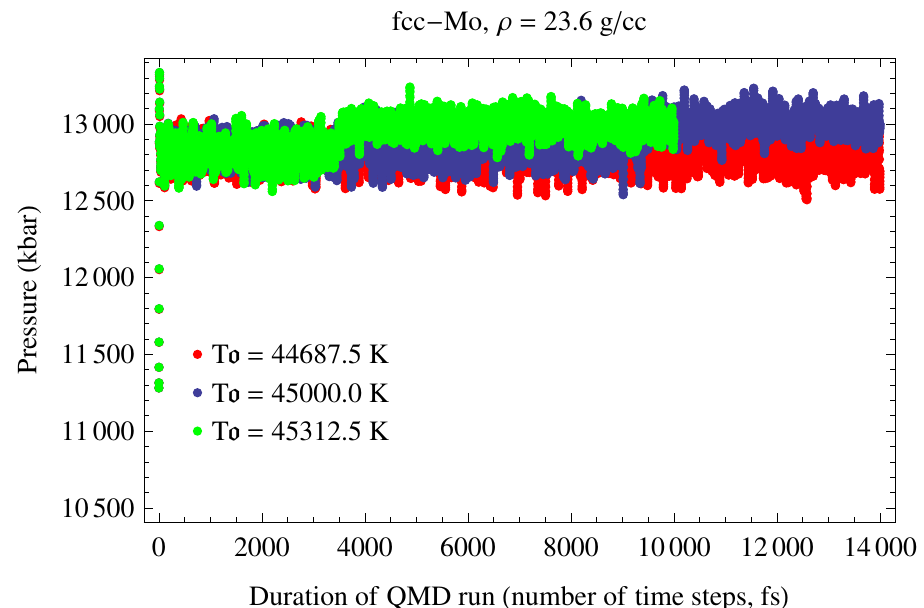
Figure 9. The same as in Figure 9 for the time evolution of pressure (in kbar; 10 kbar = 1 GPa). During melting P increases from ∼ 1280 GPa for the superheated state to ∼ 1300 GPa for the liquid at the corresponding melting